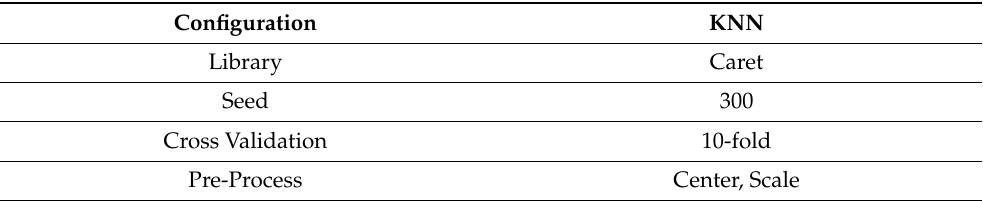
Table 4. KNN parameter configuration.